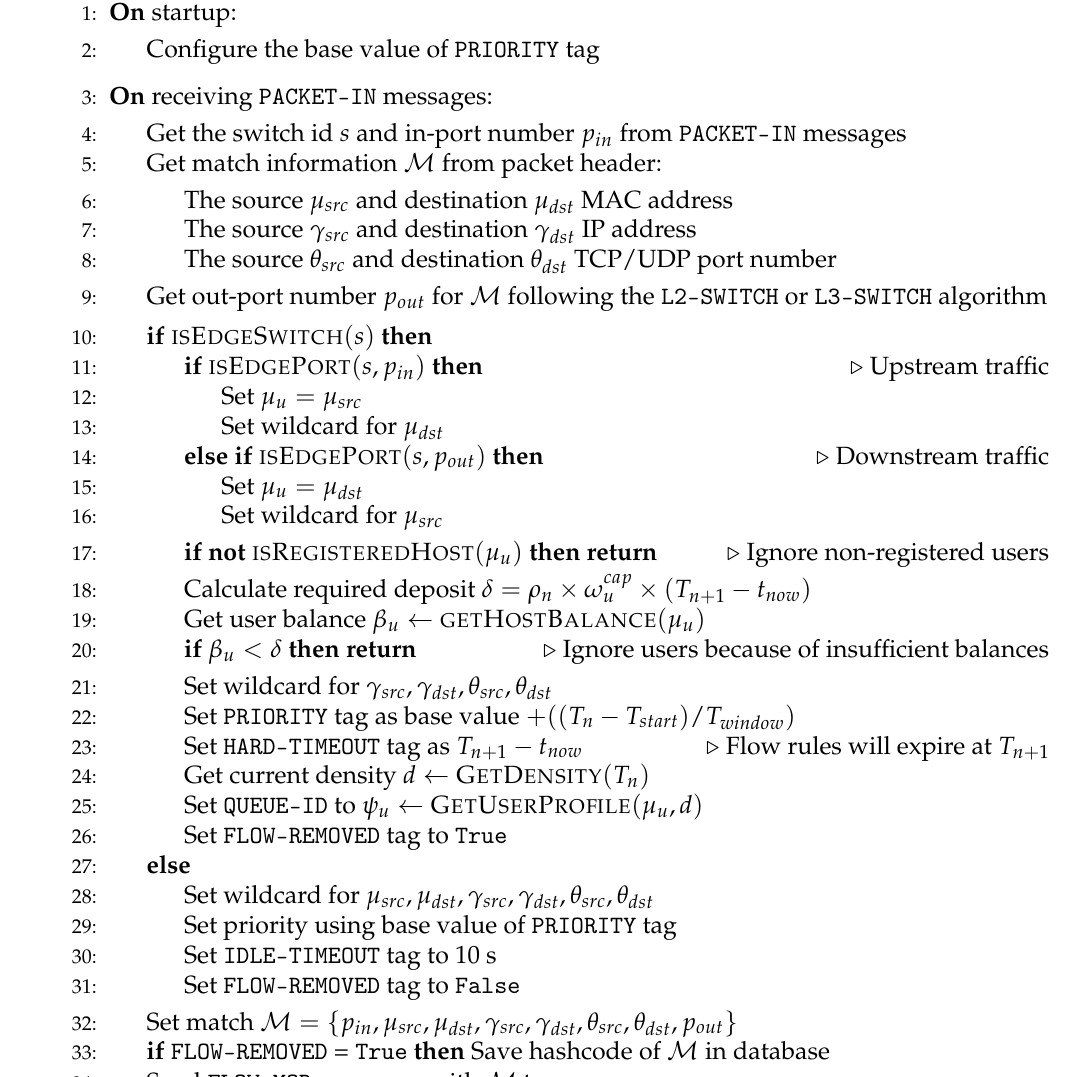
Algorithm 2 The forwarding module’s